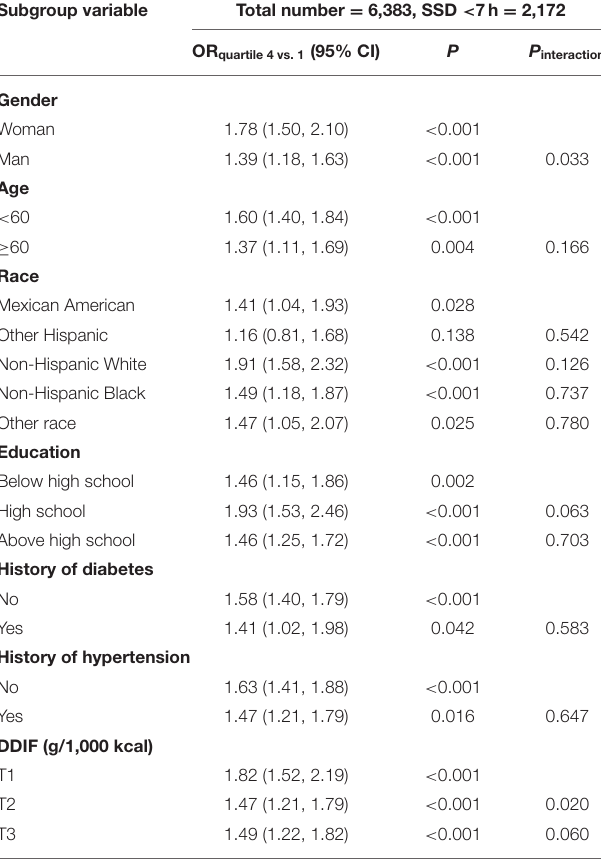
TABLE 4 | Subgroup analyses on the association between DEHP in urine and SSD < 7h. Subgroup